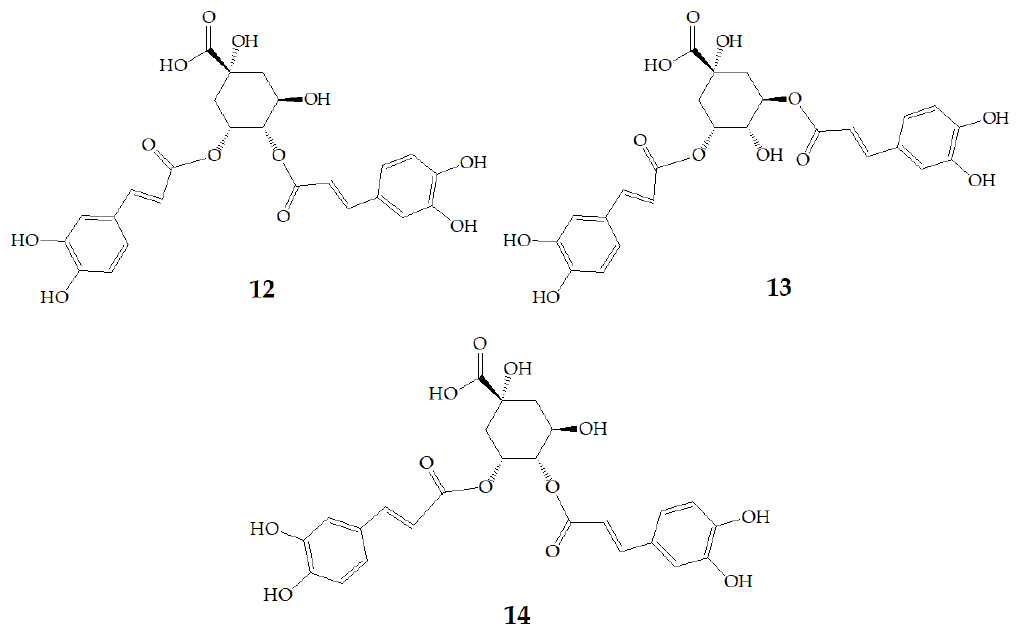
Figure 2. Chemical structures of compound 10 – 14 .